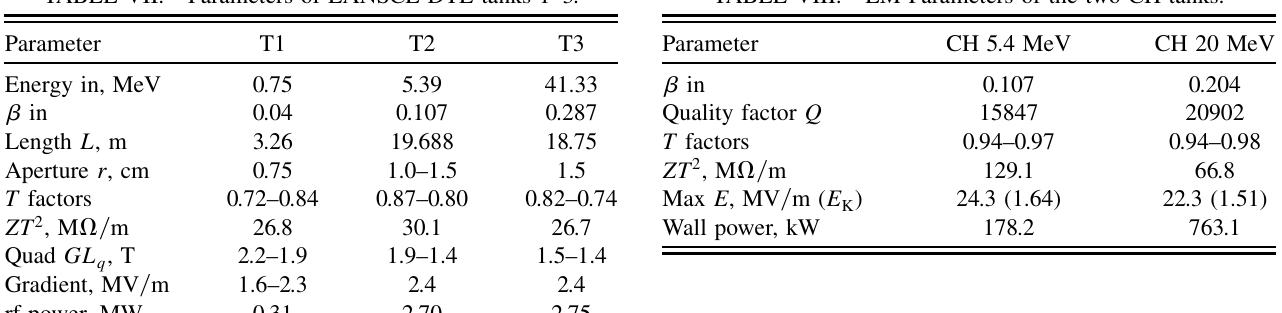
TABLE VIII. EM Parameters of the two CH tanks.